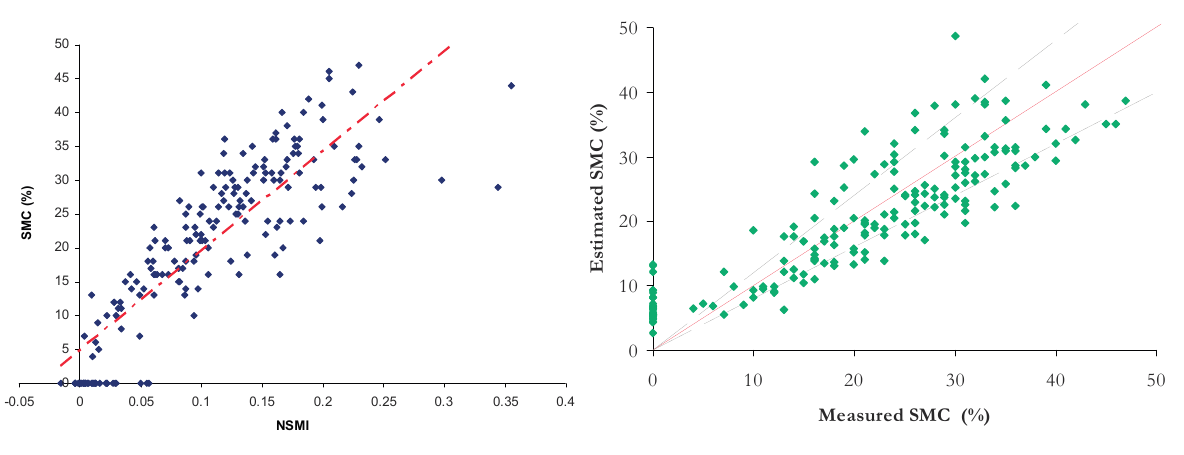
Figure 6. Variation of the SMC according to NSMI (calibration stage, Left ) and representation of estimated SMC with NSMI according to measured SMC (validation stage, Right ). The dashed black lines represent the boundaries of an error of 20%. Figure 6 represents the calibration (left) and the validation (right) stages for NSMI.